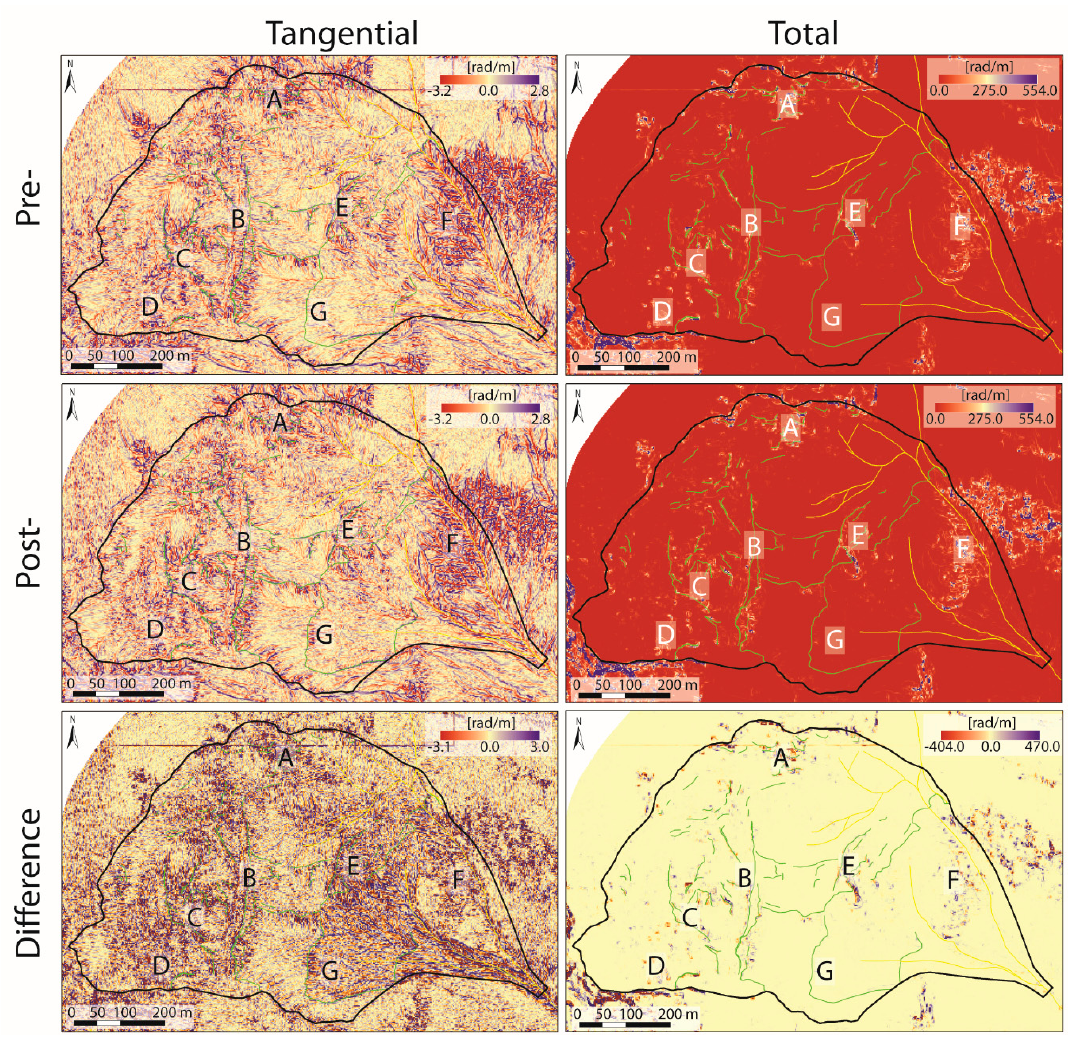
Figure 11. Pre- and post-tangential and total curvatures and their differences. A–G localize the areas affected by the main morphological changes. The light green lines highlight forms related to gravity (e.g., minor crowns, lithostructural and morphological scarps, counterscarps, crests, and trenches), and the yellow lines represent the creek and the artificial channels.